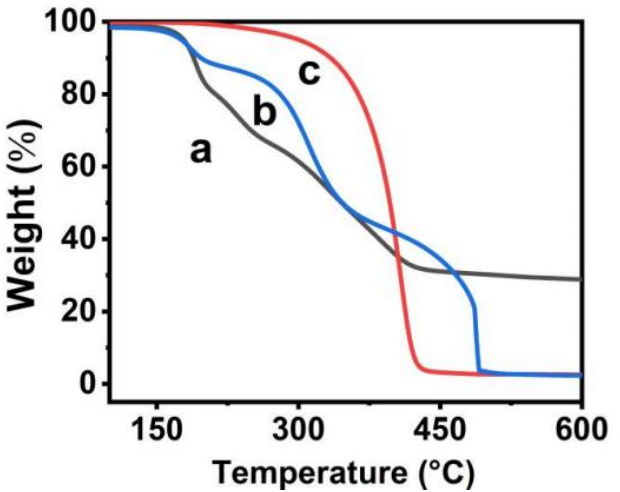
Figure 8. TGA spectra of GO (a), QDs/polymer/GO-fluorescence nanohybrid (b) and free block co- polymer brushes (c) PNIPAM- b -P(St- co -MQ).